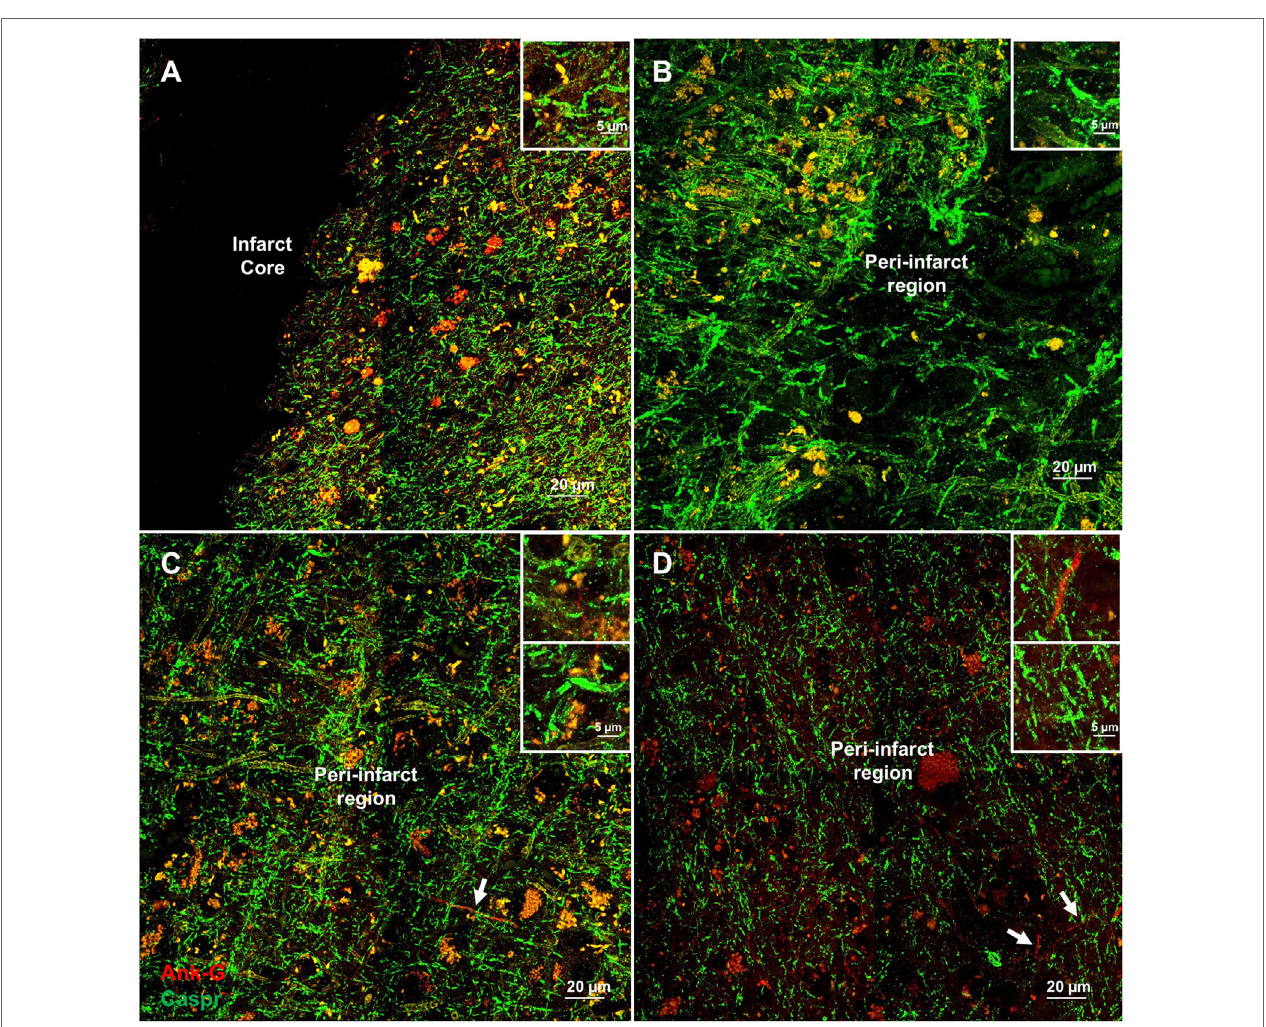
FigUre 3 | Additional examples of axonal microdomain disruption are apparent immediately adjacent to microinfarcts. Elongated and irregular contactin-associated protein (caspr)-positive paranodes (green) are frequently seen (a) . In tissue adjacent to, but some distance from the infarct core (300–350 µm away from infarct core), axonal microdomains remain disrupted with irregular morphology of paranodal regions [inset (b) ]. In some instances, Ankyrin-G (Ank-G)-positive axon initial segments can be identified [arrowheads, insets (c,D) ]. Inset: magnification × 60, scale bar = 5 µm.